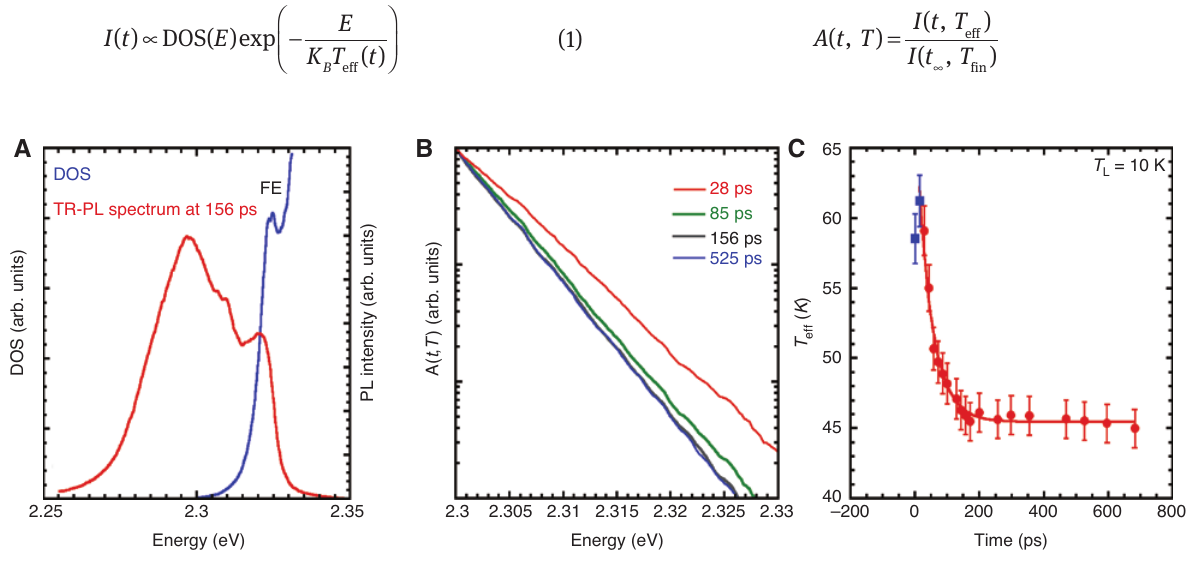
Figure 4: Bulk sample. (A) Density of states (DOS) extracted from time-resolved photoluminescence (TR-PL) spectra, as discussed in the text, along with a TR-PL spectrum at 10 K. (B) A ( t , T ) for different time delays (log scale). (C) Effective temperature of the carriers T points refer to a thermal distribution, while the blue ones refer to an incomplete thermalization condition. The solid line in (C) is a fit with Eq. (2).